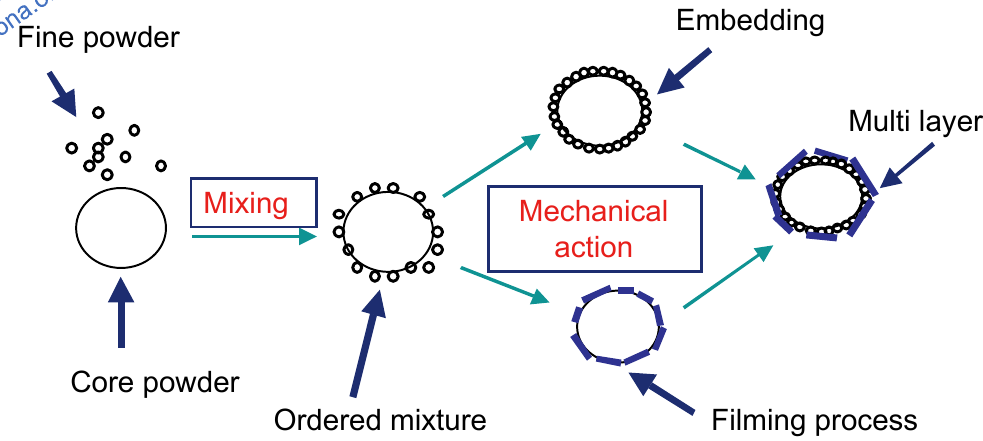
Fig. 1 Schematic principle of dry